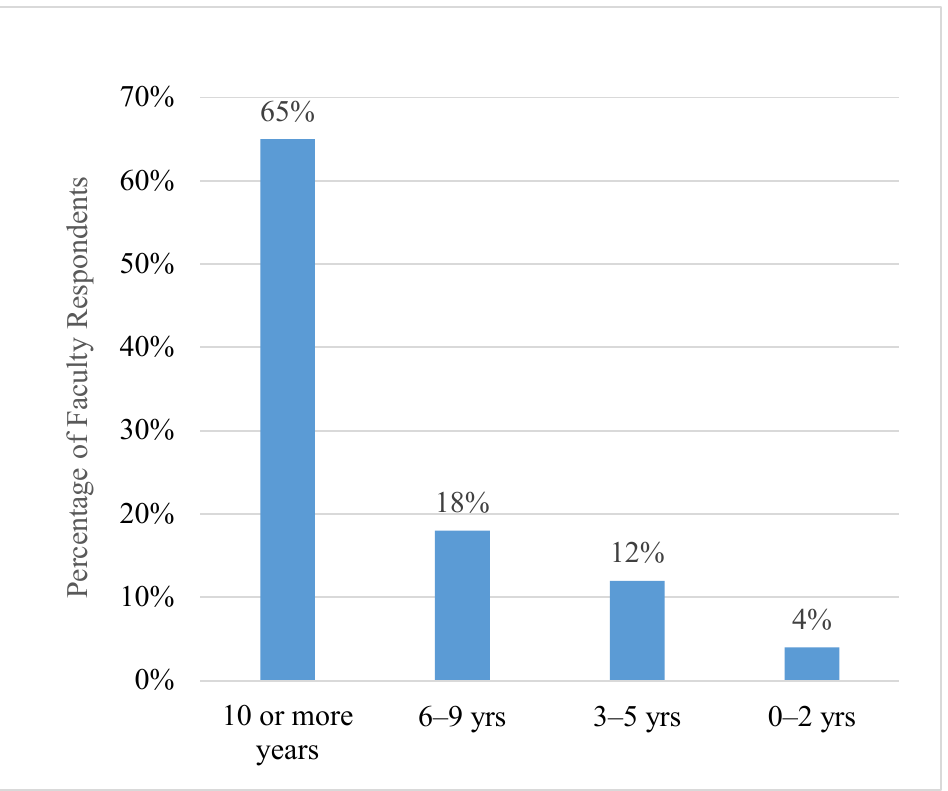
Figure 1 . Years of teaching